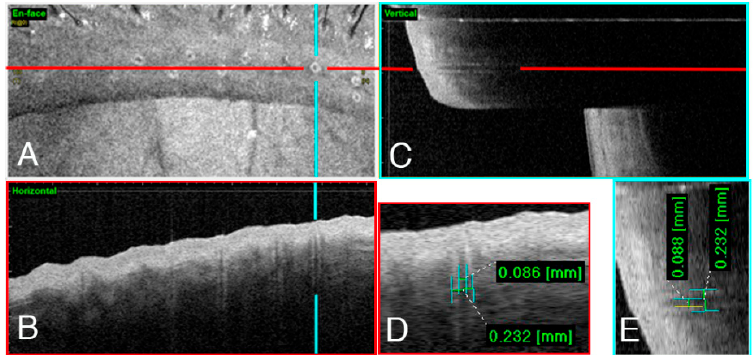
Figure 1. ( A ) En-face image of an eyelid margin scanned by Anterior Segment Optical Coherence Tomography (AS-OCT). Red and blue lines indicate the position of ( B ) horizontal and ( C ) vertical lining scans with maximal tube diameters, respectively. ( D , E ) The inner and outer diameters of the meibomian openings from horizontal and vertical images.